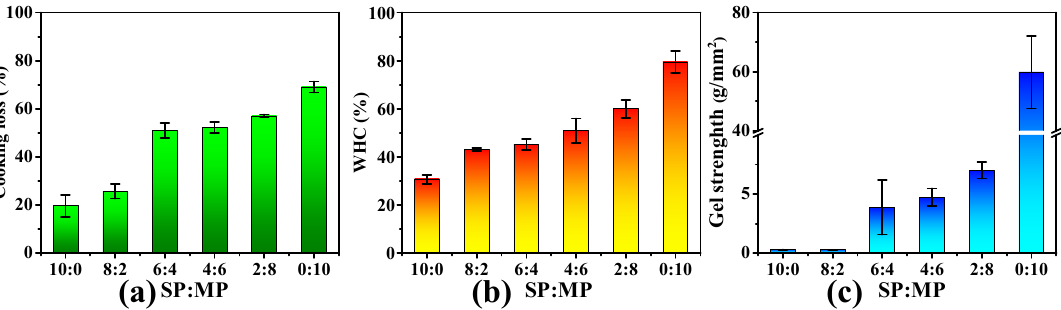
Figure 6. ( a ) Cooking loss; ( b ) water holding capacity (WHC); and ( c ) gel strength in the SP and MP system with various SP/MP proportions after heating at 90 °C for 1 h.